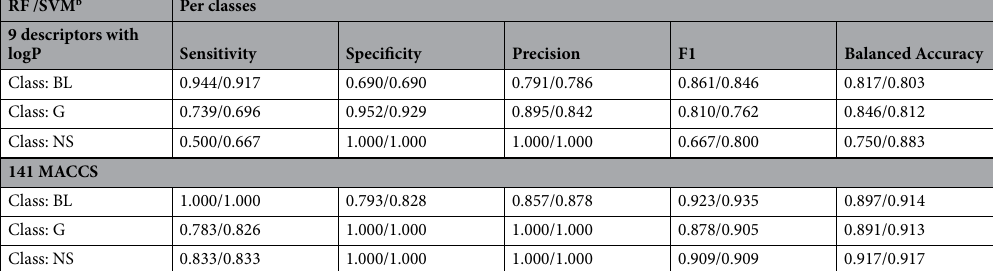
Table 3. Comparison of performance metrics on the test set of 3-class RF and SVM models built for prediction of BL, G or NS weed selectivity of herbicides in terms of subset of nine simple molecular and physicochemical descriptors including lipophilicity coefficient logP or 141 MACCS keys a . a The